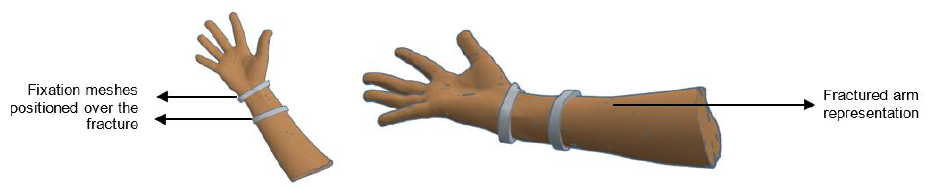
Figure A2. Representation of the fixation mesh on the fractured arm.